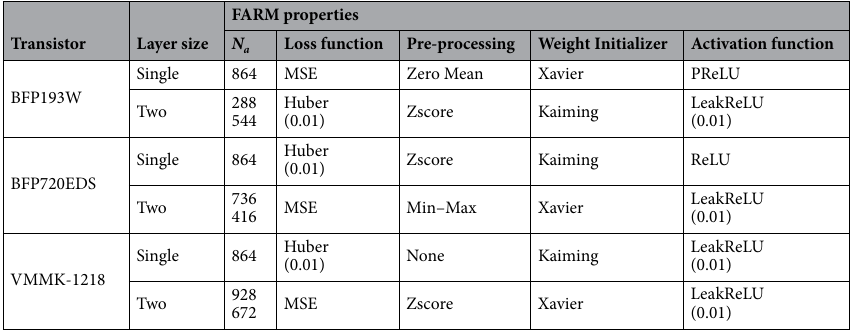
Table 4. Optimally selected farm parameters.